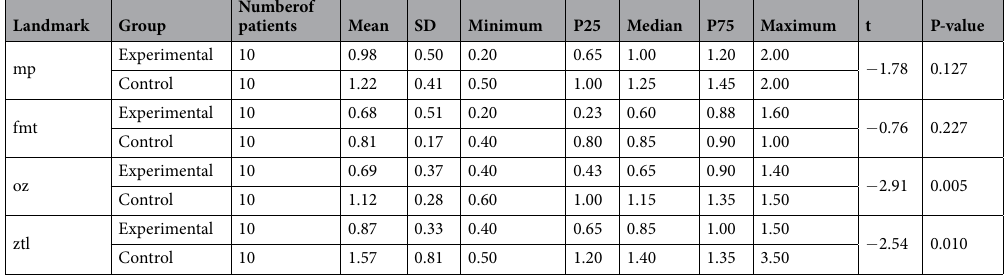
Table 3. Comparison of surgical deviation of landmarks (mm). Using the independent-sample t-test for comparisons; the statistical magnitude was